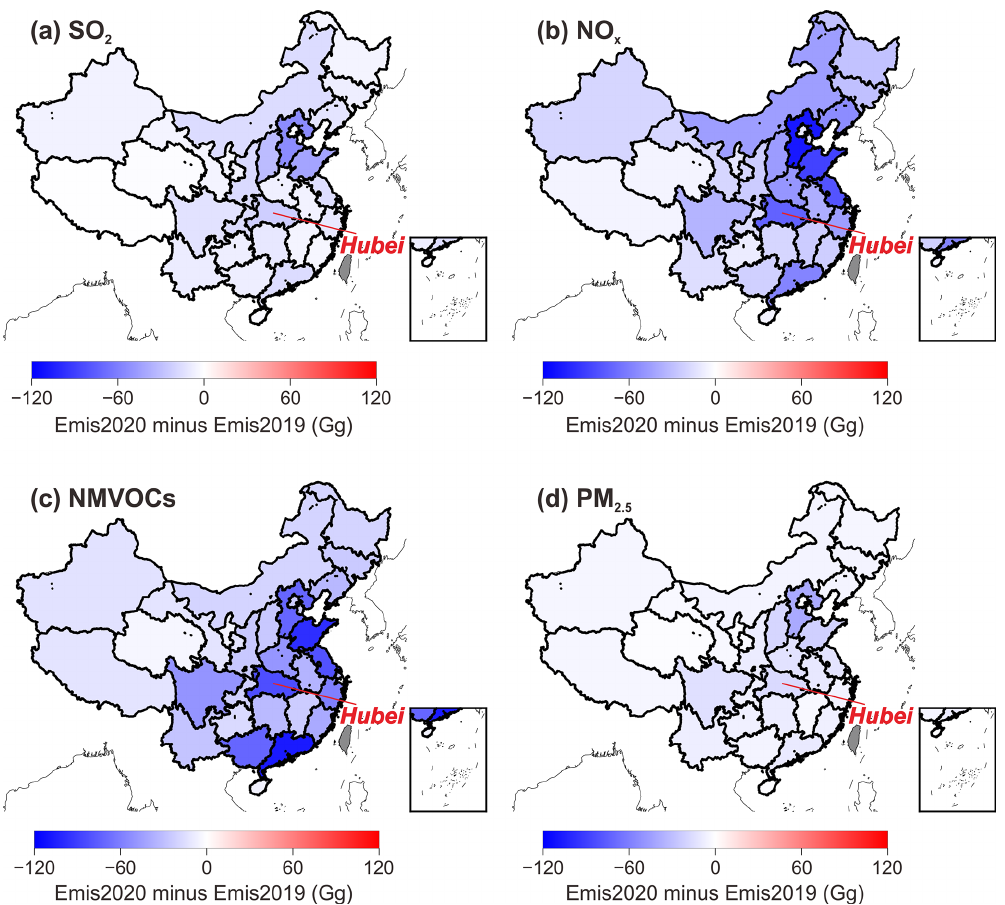
Figure 3. Differences in January–April emissions between 2019 and 2020. Four pollutants are presented including SO 2 (a) , NO x (b) , NMVOCs (c) , and PM 2 . 5 (d) . The background map shows the provincial borders in China. The color of each province represents the emissions from January to April in 2020 minus the emissions from January to April in 2019. The grey color represents the province whose data are not estimated in this